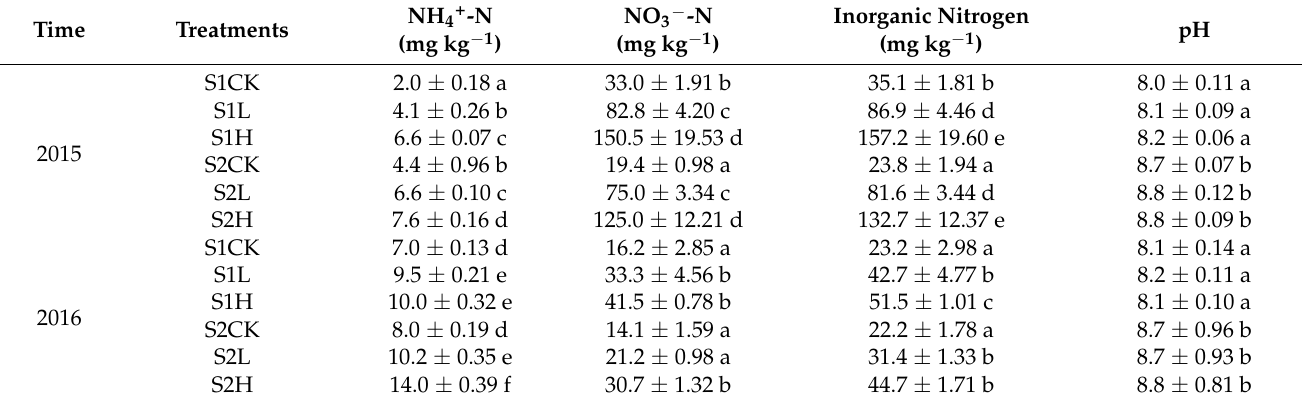
Table 4. The chemical properties of different saline and fertilized